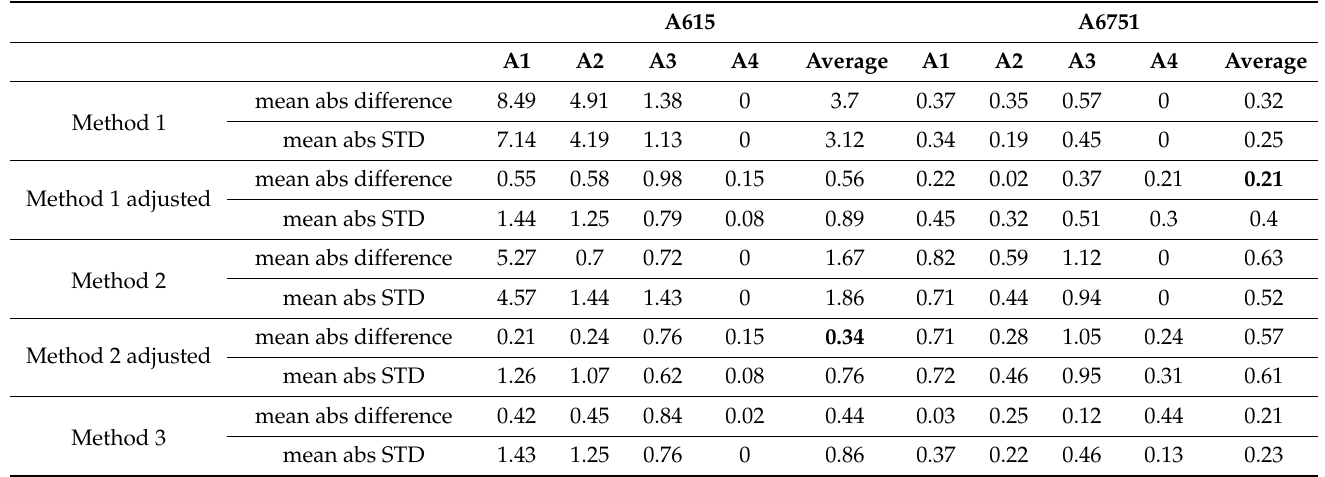
Table 1. Comparison of methods, differences between individual time–temperature curves and the reference curve ( ◦ C). Best average results for each camera are in